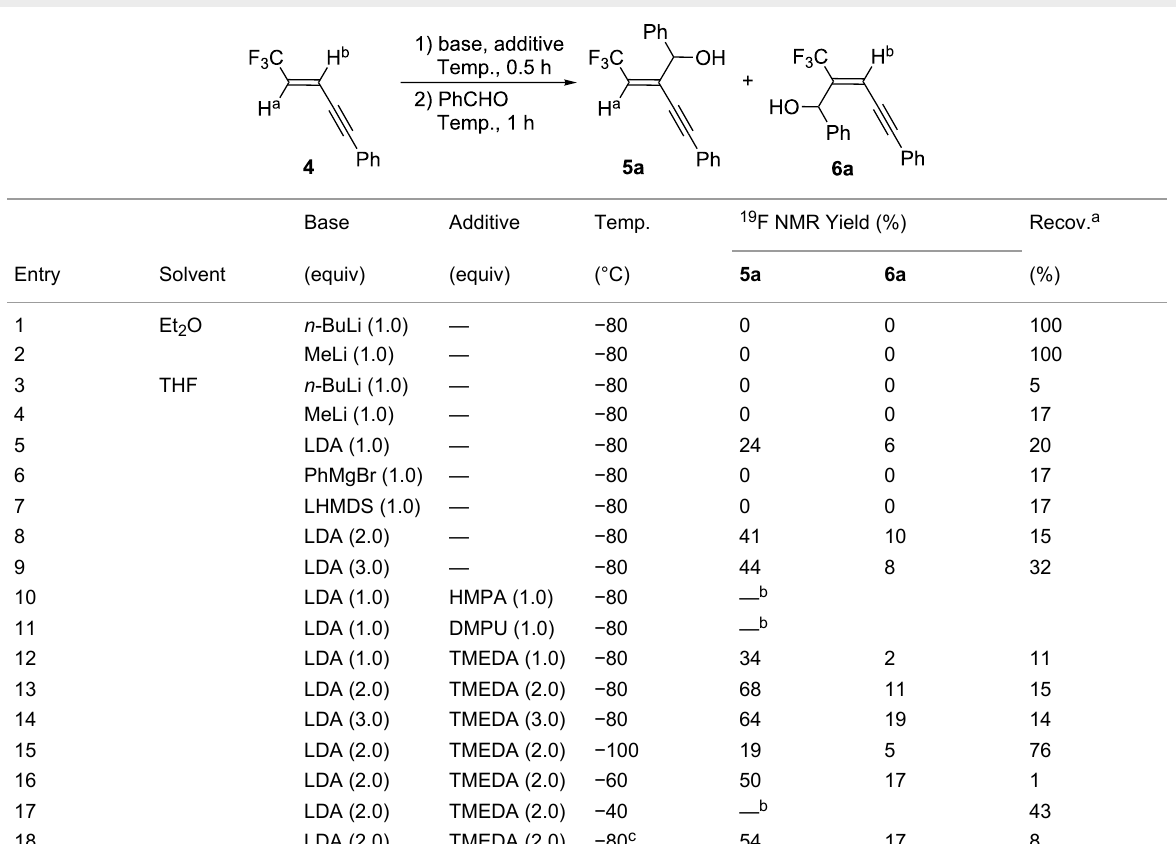
Table 1: Investigation of reaction conditions.